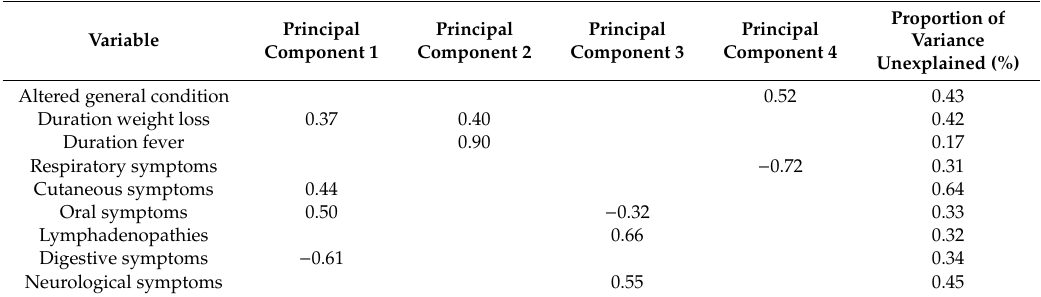
Table 2. Factor loadings with correlations > [0.3] for the four main principal components for clinical signs and symptoms leading to diagnosis.